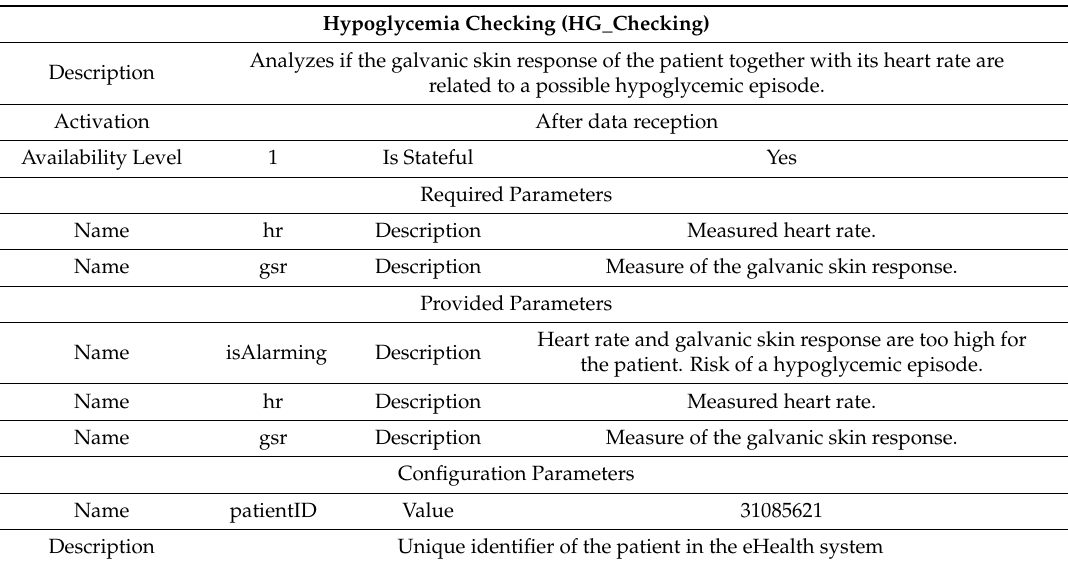
Table 2. Characterization of the HG_Checking component.